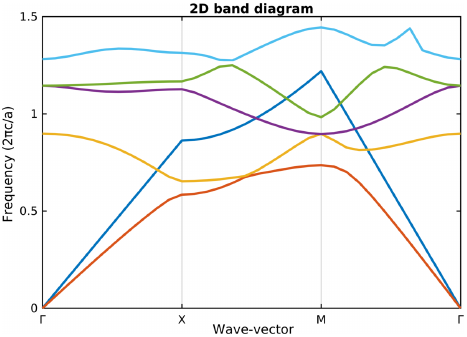
Figure 4. Band diagram of the structure depicted in Figure 2. Each color represents a different Bloch